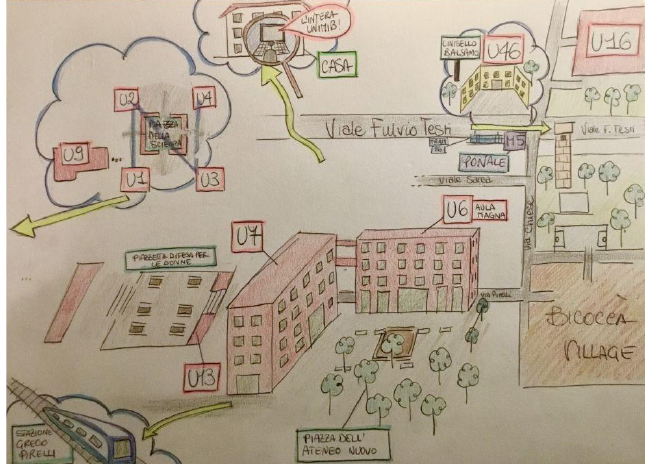
Figure 3 Drawing from the second workshop – Bicocca from a Student’s point of